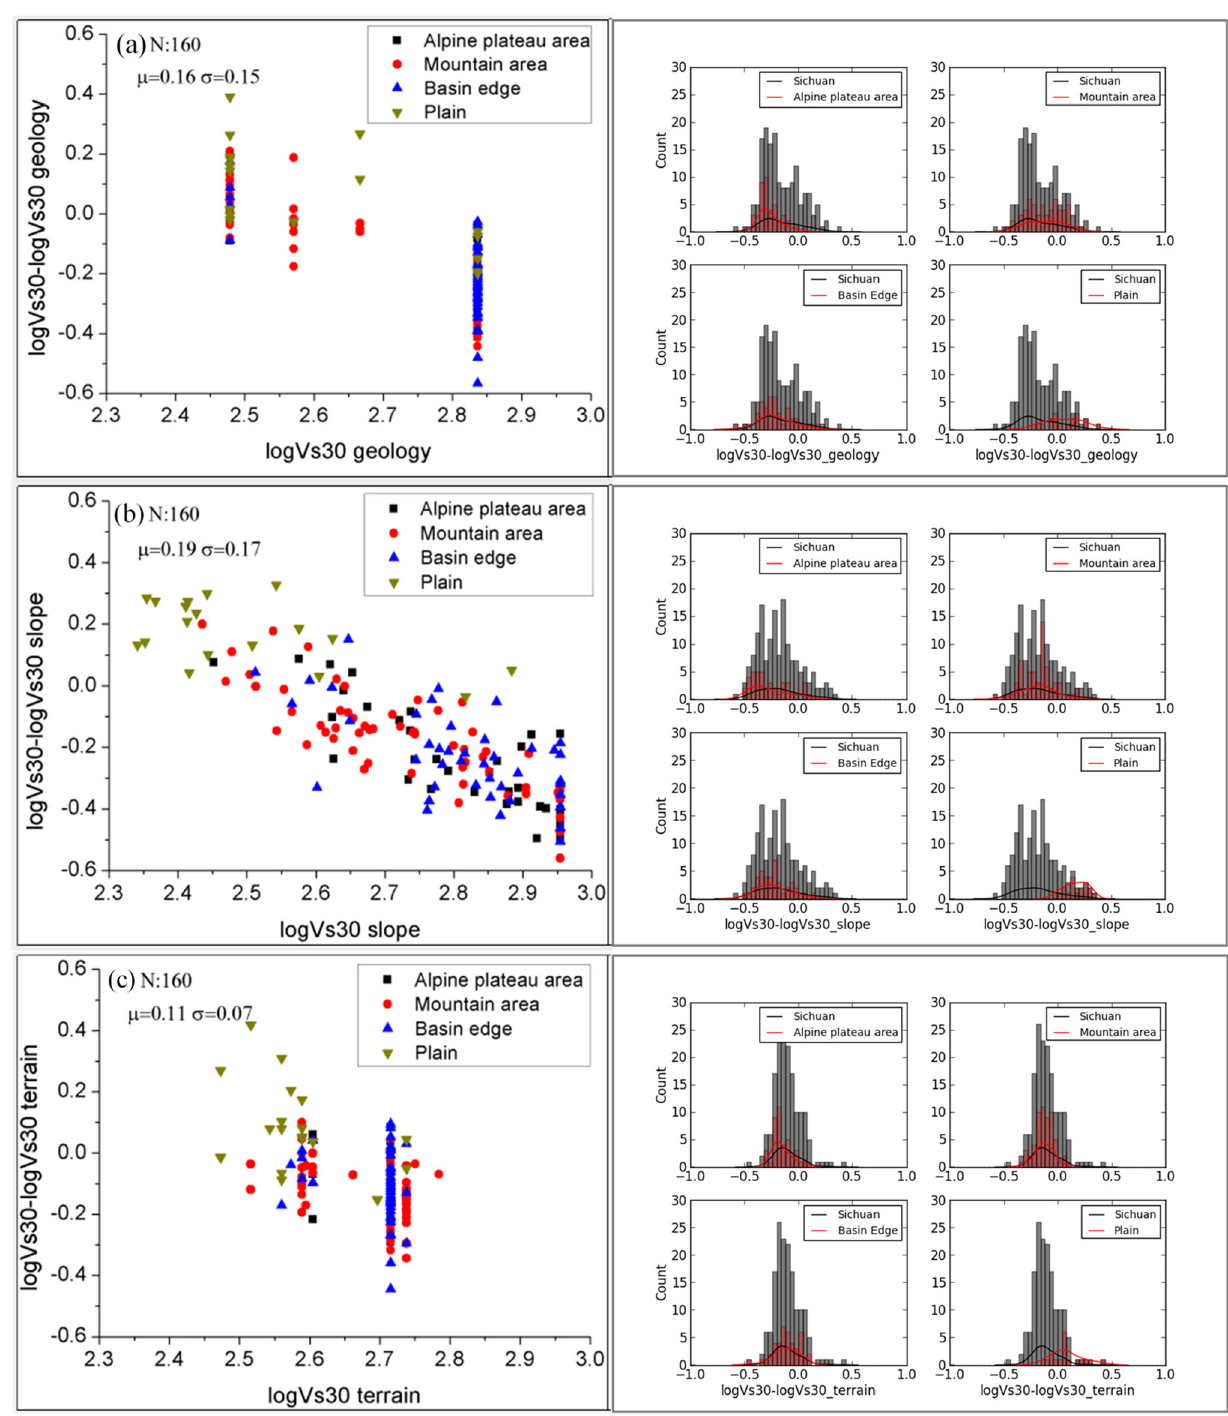
Fig. 6 Normalized count distribution for each of three approaches in each geological area in Sichuan Province. The left side shows the residual distribution of logV s30 values (measured logV s30 ) and estimated logV s30 values using: a the geology-based approach; b the topographic slope-based approach; and c the terrain-based